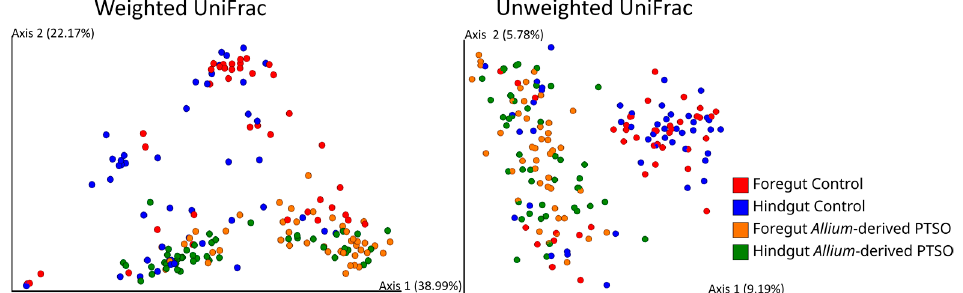
Figure 5. Dimensional figures showing the first two axes of principal coordinate analysis and representing bacterial communities of foregut and hindgut of juvenile European seabass fed with control diet or supplemented with Allium- derived PTSO using unweighted and weighted UniFrac distance matrixes. Samples are colored by gut region and experimental diet (foregut control—red; hindgut control—blue; foregut Allium- derived PTSO—yellow; hindgut Allium- derived PTSO—green). Proportion of explained variance by each PCo axis is shown.